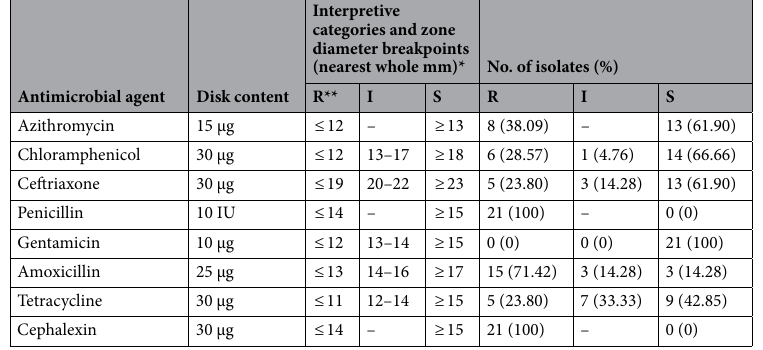
Table 5. Antibiotic resistance profile of Salmonella spp. isolates (n = 21) from bovine milk samples. *From CLSI 31 . ** S susceptible, I intermediate, R resistant.